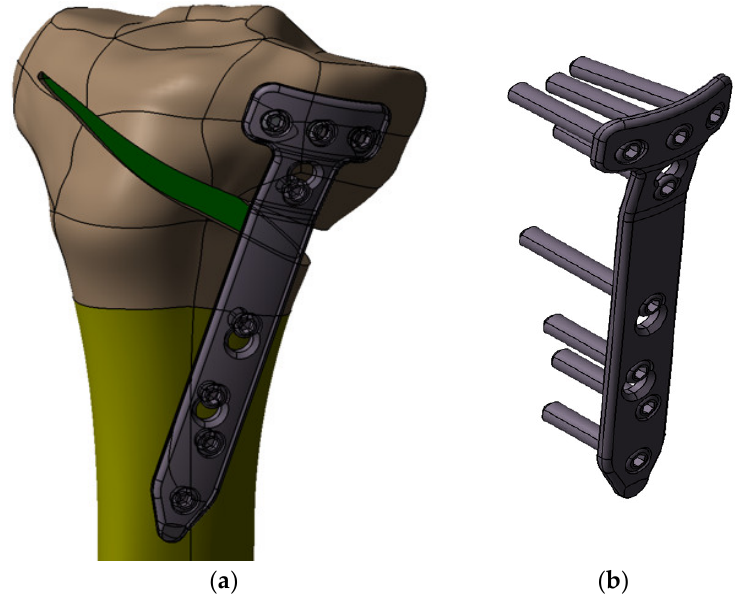
Figure 7. 3D modelling of the OWHTO with TomoFix Medial High Tibial Plate.